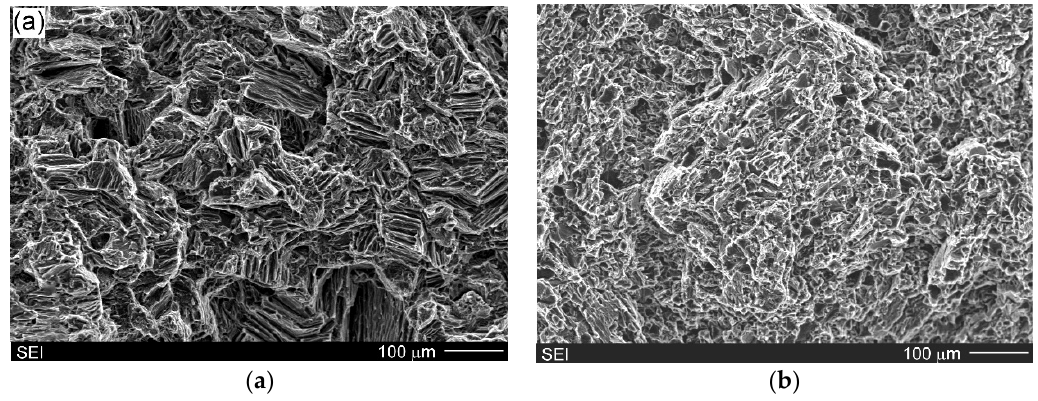
Figure 9. SEM micrographs of fracture surface of Mg/Mg 2 Si–HO ( a ) and Mg/Mg 2 Si–HR ( b ) composites (after uniaxial tensile test).